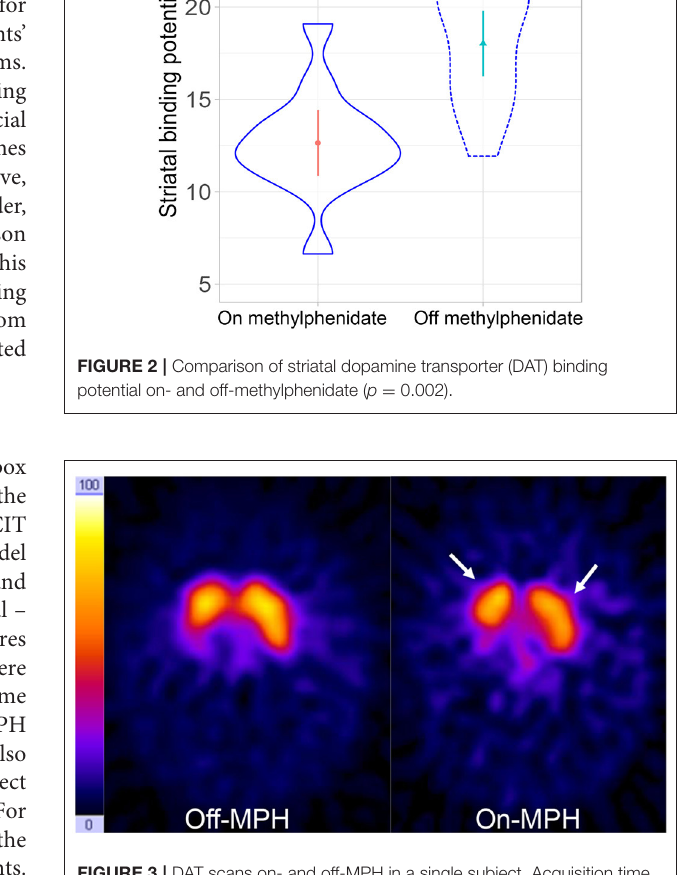
FIGURE 3 | DAT scans on- and off-MPH in a single subject. Acquisition time points were 24h after tracer application. Color scale is hot metal. Time span between the two images was 7 days. On the right side, a decrease of tracer accumulation in the basal ganglia can be seen